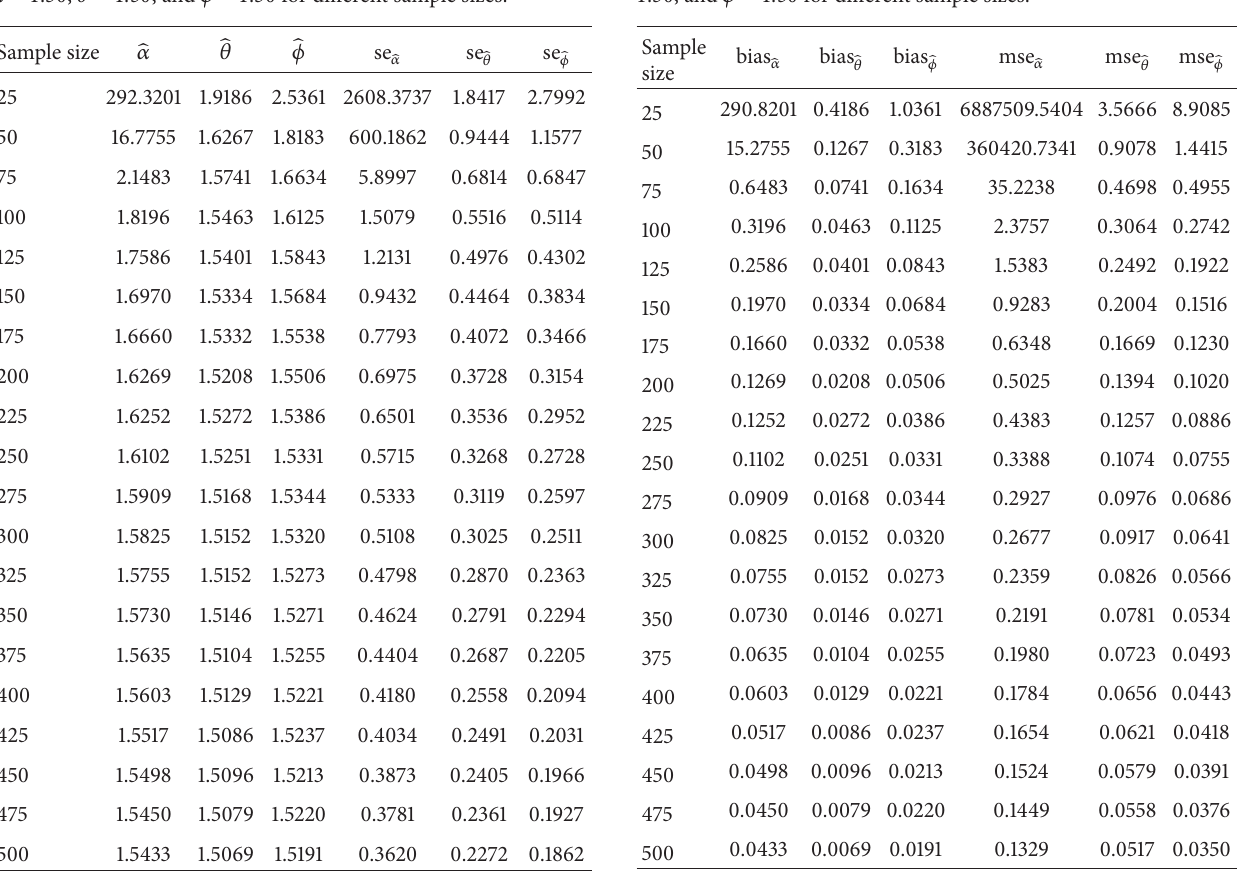
Table 4: Monte-Carlo simulation results of the estimators bias and mse of the EG type-2 distribution with parameters: 𝛼 = 1.50 , 𝜃 = 1.50 , and 𝜙 = 1.50 for different sample